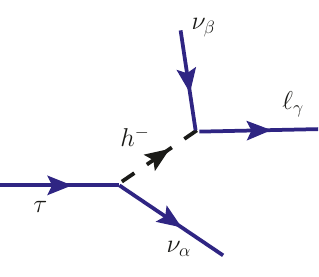
Figure 13 . Feynman diagram for the new decay mode of the (cid:28) lepton mediated by light charged scalar in the Zee